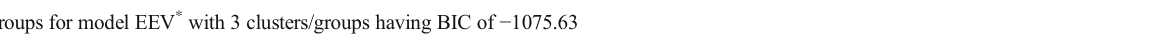
Mean values of DPI3-weighted, No. of Total Hazards and No. of Low-speed Warnings for model EEV with BIC of − 1075.63 Groups for model EEV * with 3 clusters/groups having BIC of − 1075.63 Group